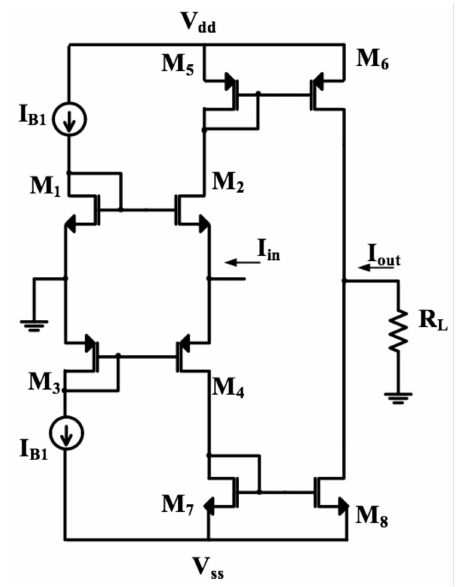
Figure 2. Conventional class AB current buffer